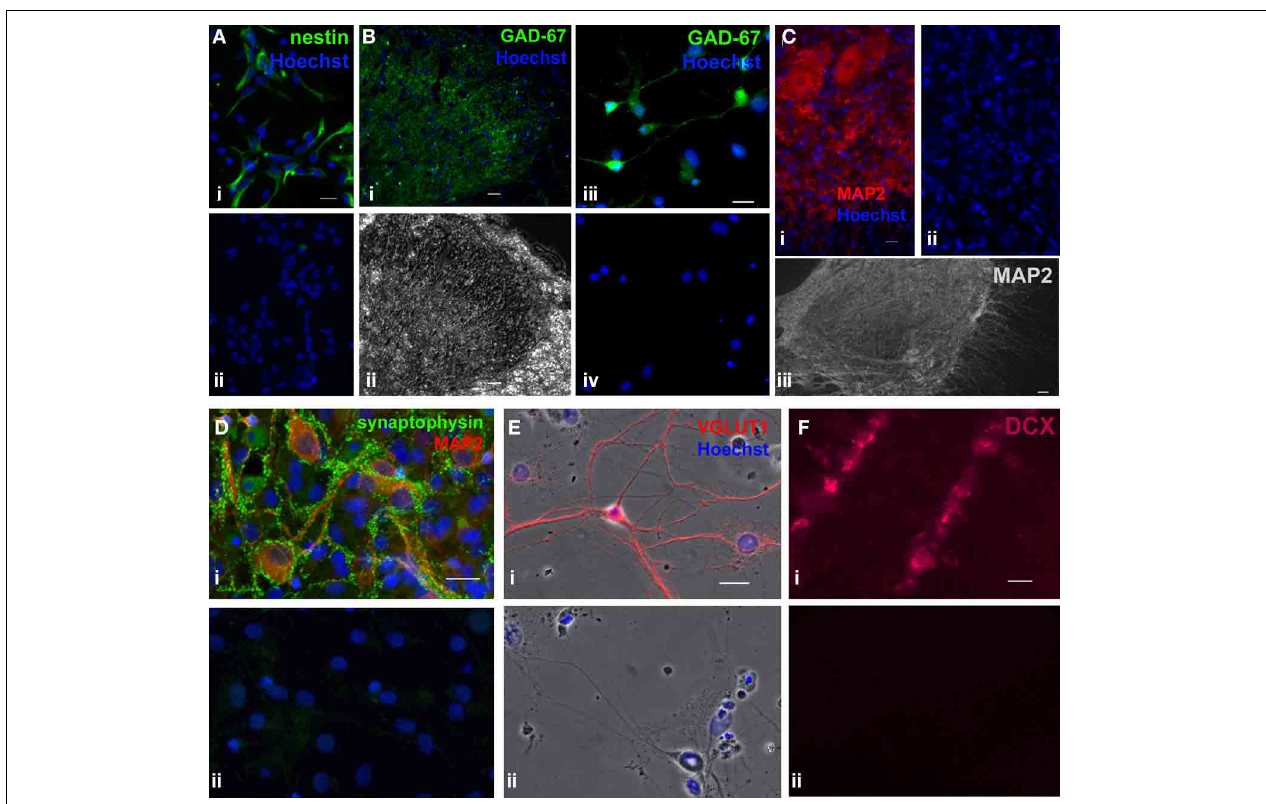
FIGURE 6 | Immunostaining controls of primary antibodies used in the study. As positive controls, primary antibodies used in the study were tested in different cell types or tissues where they have been detected in previous studies. (A) , Immunostaining of mouse monoclonal nestin (green) in hippocampal progenitor cell culture from embryonic day (E) 18 rat embryos (1DIV), where the majority of the cells were nestin + (i) [previous reported in (Mistry et al., 2002)]. (ii) Negative control where the primary antibody was omitted. Scale bar: 20 μ m. (B) i,ii, Immunostaining of mouse monoclonal GAD-67 (green) in an adult rat spinal cord section. (i) Fluorescent image showing that GAD-67 immunoreactivity was localized in lamina II of the dorsal horn, which matches the typical staining pattern of GAD-67 in the spinal cord (Edgerton et al., 2001). (ii) Phase contrast image of the same dorsal horn field. Scale bar: 20 μ m. (B) iii,iv, Immunostaining of rat postnatal day 7 hippocampal culture (16DIV) using mouse monoclonal GAD-67 antibody. (iii) GAD-67 staining (green). (iv) Negative control in which the primary antibody was omitted. Scale bar: 20 μ m. (C) , Immunostaining of mouse monoclonal MAP2 in adult rat spinal cord sections. (i) MAP2 staining (red) in ventral horn neurons. Scale bar: 20 μ m. (ii) Negative control where